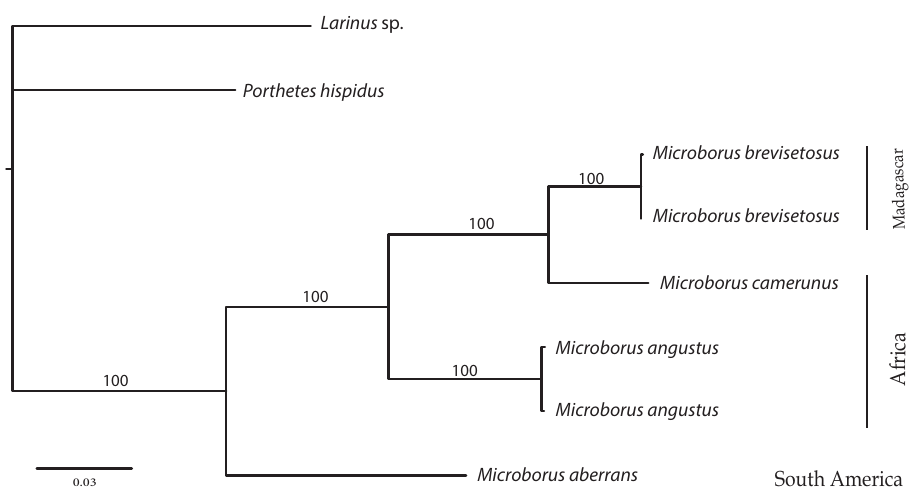
Figure 21. Maximum likelihood phylogeny based on six gene fragments and a GTR model of gene evolution. Tree topology and bootstrap values were identical in the maximum parsimony analysis (L = 1657, CI = 0.85, RI =